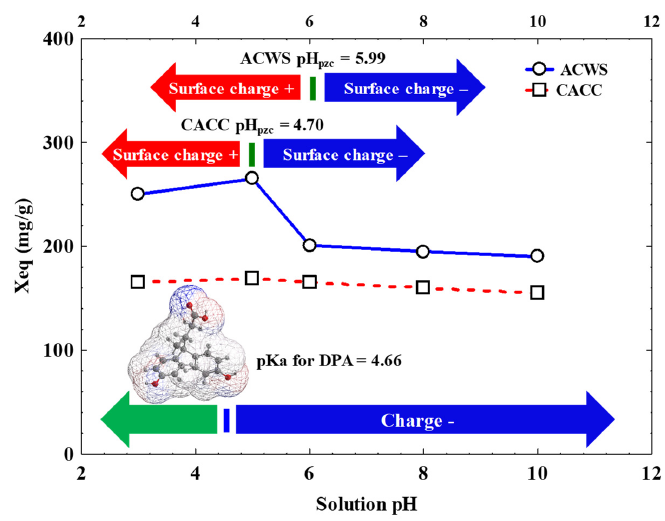
Figure 7. Influence of solution pH on the adsorption of DPA on ACWS ( ○ ) and CACC ( □ ) at T = 25 °C and [C] o = 500 mg/L. and [C] o = 500